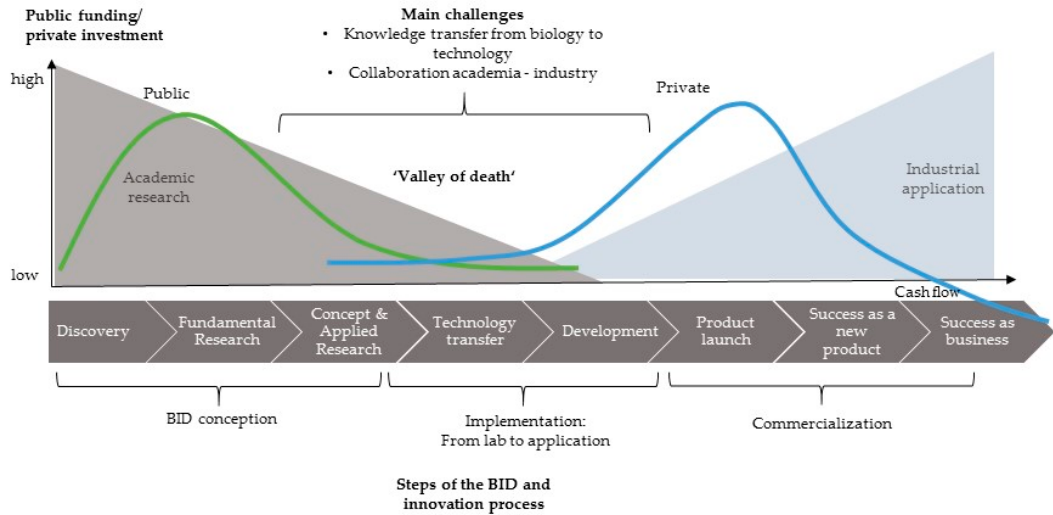
Figure 2. The “valley of death” in innovation and the context of the simplified BID process. Based on and adapted from [46,47]. BID: Biologically inspired design.